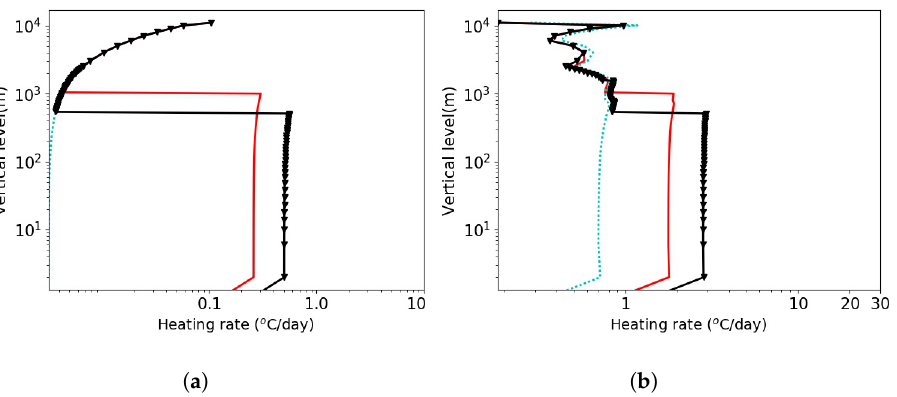
Figure 3. Heating rate in the atmospheric layers on 18 February 2007 at 1500 (UTC) for the UV-vis band ( a ) and for the SIR band ( b ) (in °C/day) — base case; - - - no aerosols in the modeling of irradiance fluxes; -v- aerosol boundary layer of 500